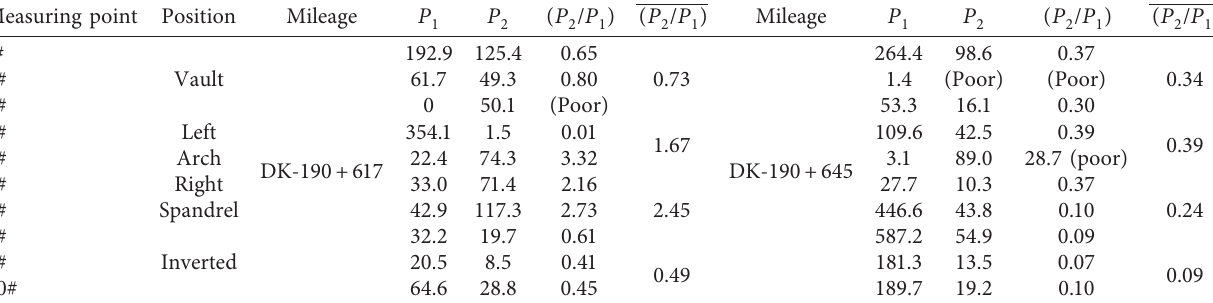
Table 2: Load sharing of primary support and secondary lining.